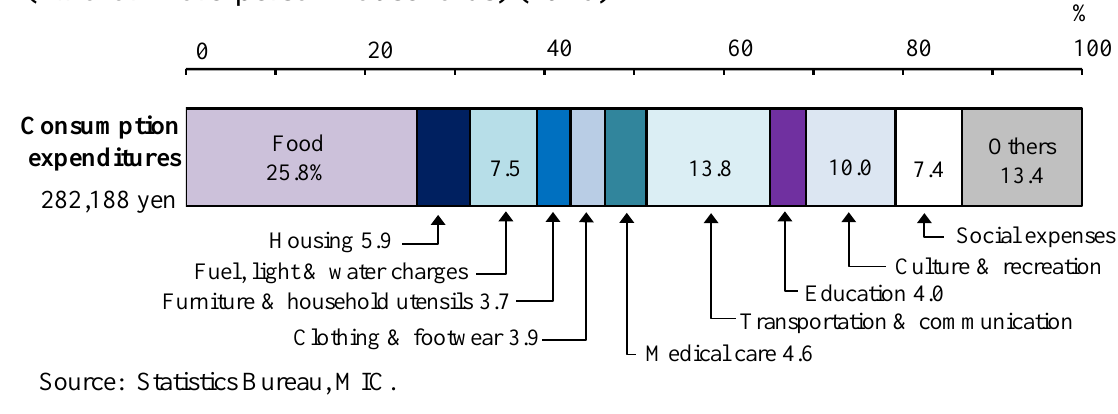
Average Monthly Consumption Expenditures (Two-or-more-person households)